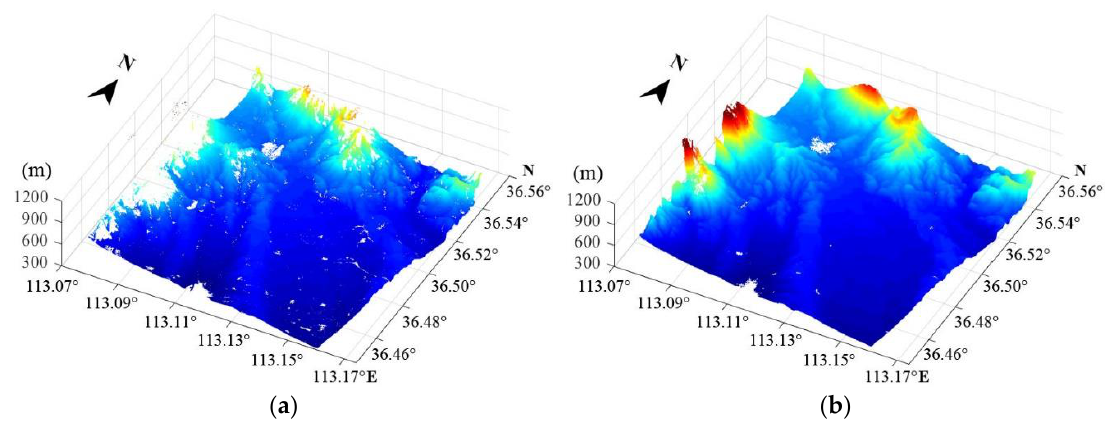
Figure 16. The effective elevation distributions obtained by Yaogan-29 ( a ) and Gaofen-3 ( b